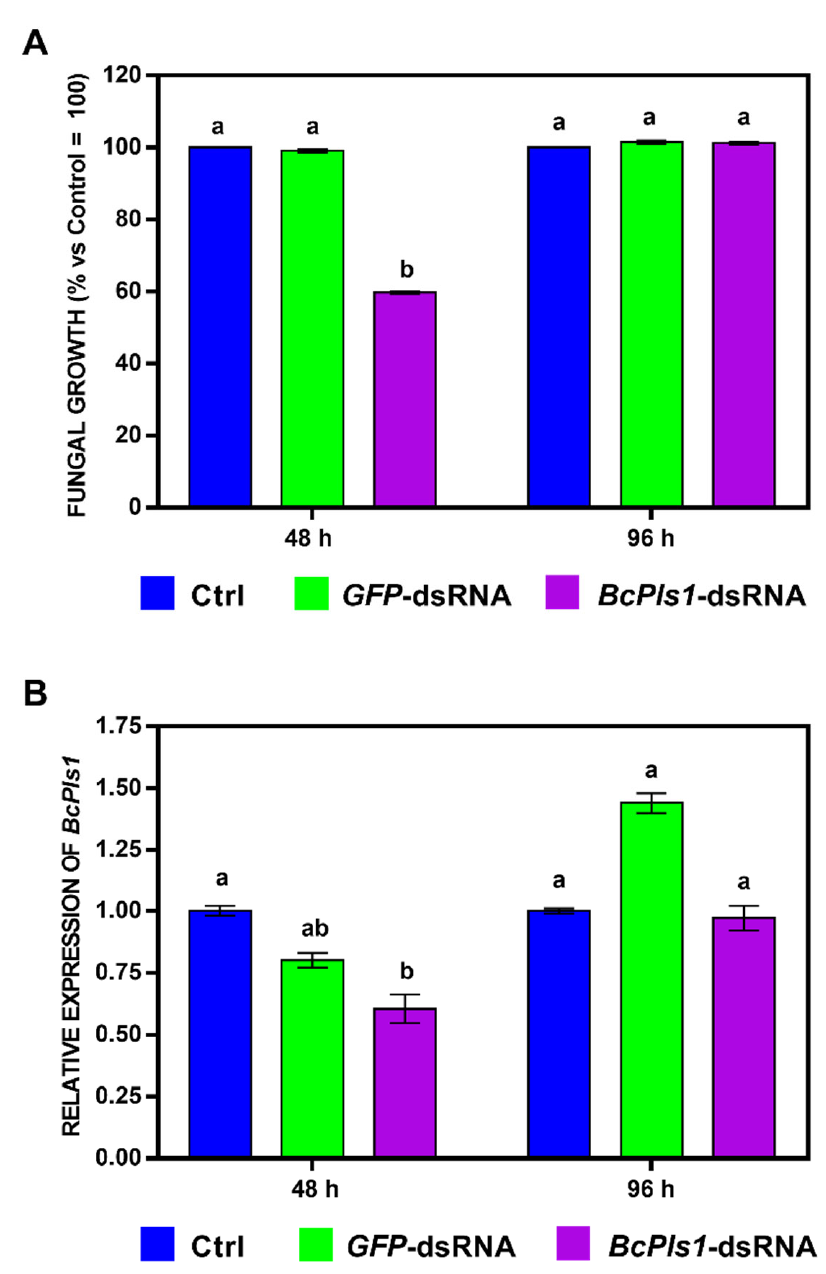
Figure 2. In vitro effects of BcPls1 -dsRNA on fungal growth and relative expression levels of the target gene BcPls1 . ( A ) Fungal growth was assessed by measuring the optical density (OD 595 ) at 48 and 96 h in 96-well microtiter plates. In each well, there were aliquots of a conidial suspension of B. cinerea B05.10 (5 × 10 2 spores) in SMB medium and 2 µ g of dsRNA ( GFP -dsRNA (green) or BcPls1 -dsRNA (purple)). SMB + TE buffer was used as control (Ctrl, blue). The graph shows the mean ( ± SE) of three independent experiments with eight biological replicates ( n = 8). Same letters above the bars indicate no significant differences from each other (ANOVA) according to Tukey’s HSD test ( p ≤ 0.05). ( B ) Expression of BcPls1 mRNA in mycelium of B. cinerea B05.10 treated with GFP -dsRNA or BcPls1 -dsRNA at 48 and 96 h. SMB + TE buffer was used as control (Ctrl). Relative transcript values were calculated by qRT-PCR using Ctrl and GFP -dsRNA as reference samples and were normalized to the BctubA gene. The graph shows the mean ( ± SE) of three biological replicates ( n = 3). Same letters above the bars indicate no significant differences from each other (ANOVA) according to Tukey’s HSD test ( p ≤ 0.05). The statistical analysis was conducted separately for 48 and 96